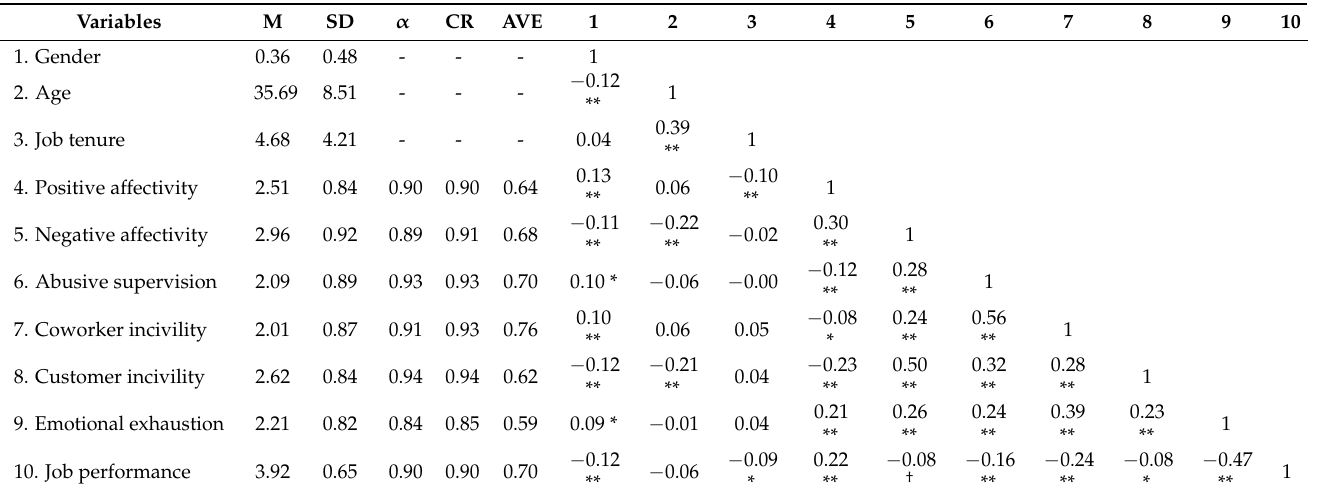
Table 2. Means, standard deviations, and correlations of all